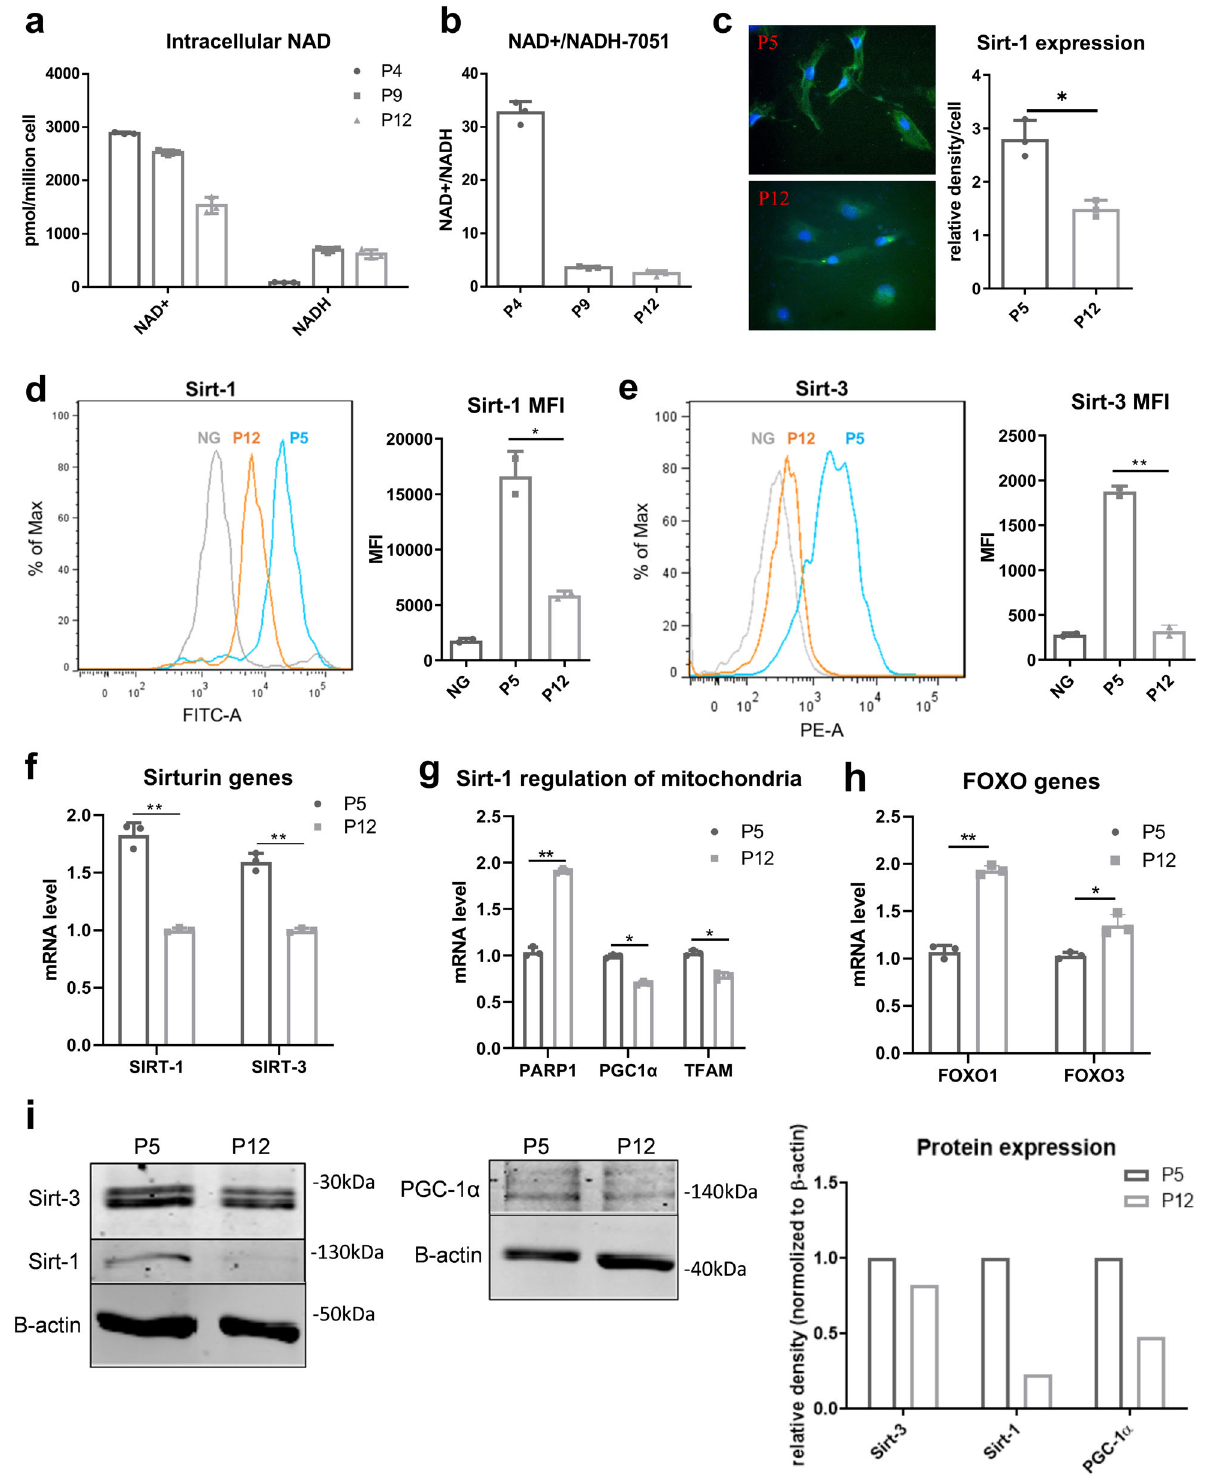
Fig. 4 NAD + /NADH-Sirtuin (Sirt) axis imbalance induced by in vitro culture expansion of human mesenchymal stem cells (hMSCs). a Intracellular NAD + and NADH levels were altered and b NAD + /NADH ratio decreased during culture expansion of hMSCs. c Immunocytochemistry of Sirt-1 expression in culture-expanded hMSCs. d Sirt-1 and e Sirt-3 protein levels characterized by fl ow cytometry. MFI mean fl uorescence intensity. f mRNA levels of Sirt-1 and Sirt-3 in hMSCs. g Genes in DNA repair and mitochondria ( PARP1, PGC1 , and TFAM ) regulated by Sirt-1 in hMSCs at different passages. h FOXO pathways ( FOXO1 and FOXO3 ) regulated by Sirt-1 and Sirt-3, determined by RT-PCR. i Sirt-1, Sirt-3, and PGC-1 α protein levels during culture expansion of hMSCs determined by Western blot. Biological replicates ( n ): n = 3. * p < 0.05; ** p <